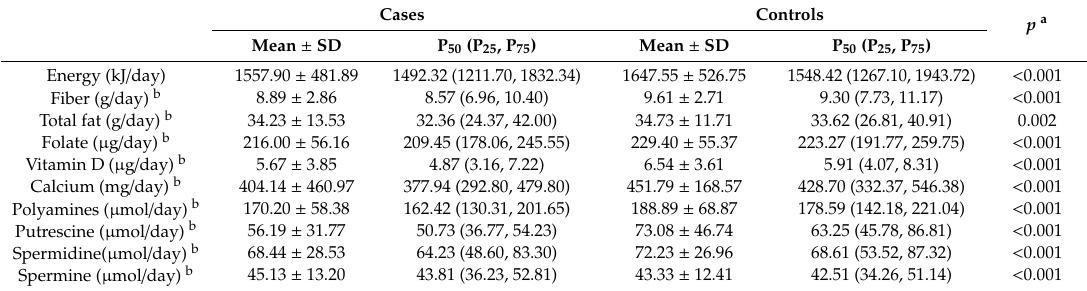
Table 2. Intakes of polyamines and kinds of nutrients among colorectal cancer cases and controls.